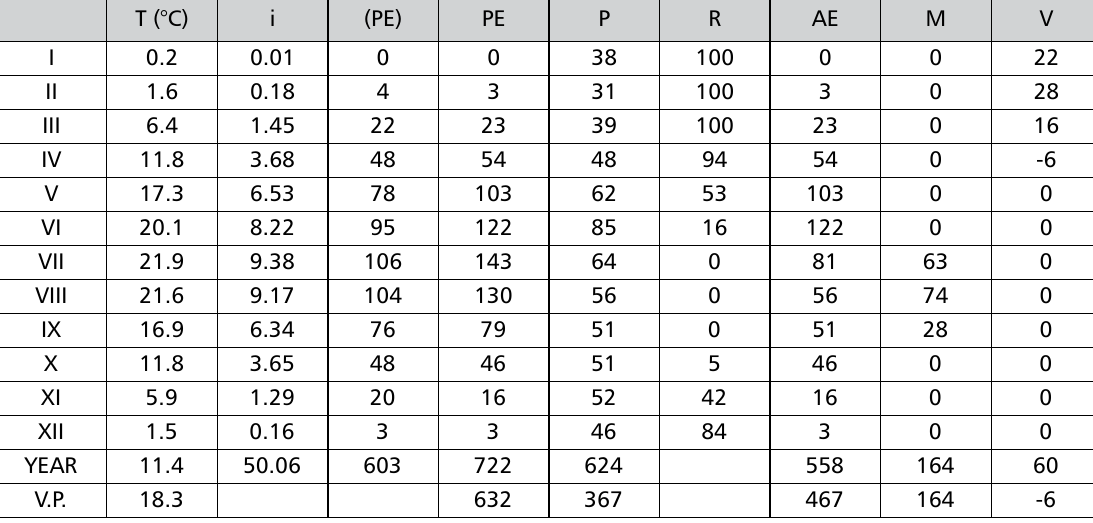
Hydrological balance according to Thornthwaite